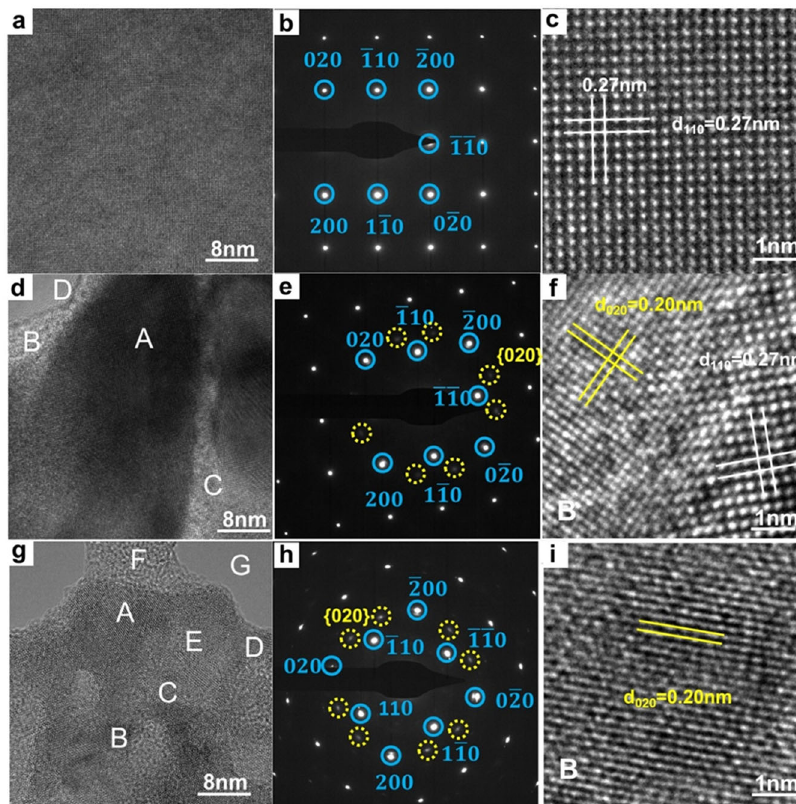
Fig. 2 TEM analysis of Bi 2 O 2 Se nanoplates. a Large-scale TEM image, b corresponding SAED pattern marked by blue circles and c close-up TEM image of pristine Bi 2 O 2 Se. The d-spacing of 0.27 nm (marked by white lines) can be assigned to the {110} planes. d Large-scale TEM image, e corresponding SAED pattern (the newly formed polycrystalline {020} planes are marked by yellow circles), and f close-up STM images of region B highlighted in panel d of the Bi 2 O 2 Se sample after short-term plasma treatment. g Large-scale TEM image, h corresponding SAED pattern and i close-up STM images of region B highlighted in panel g of the Bi 2 O 2 Se sample after long-term plasma treatment. The d-spacings of 0.27 nm and 0.20 nm (marked by yellow lines) can be assigned to the {110} planes and {020} planes,